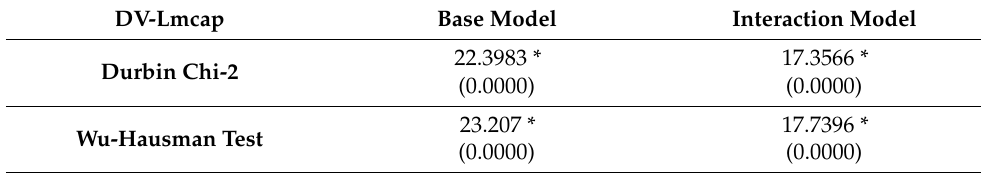
Table 4. Results of Endogeneity